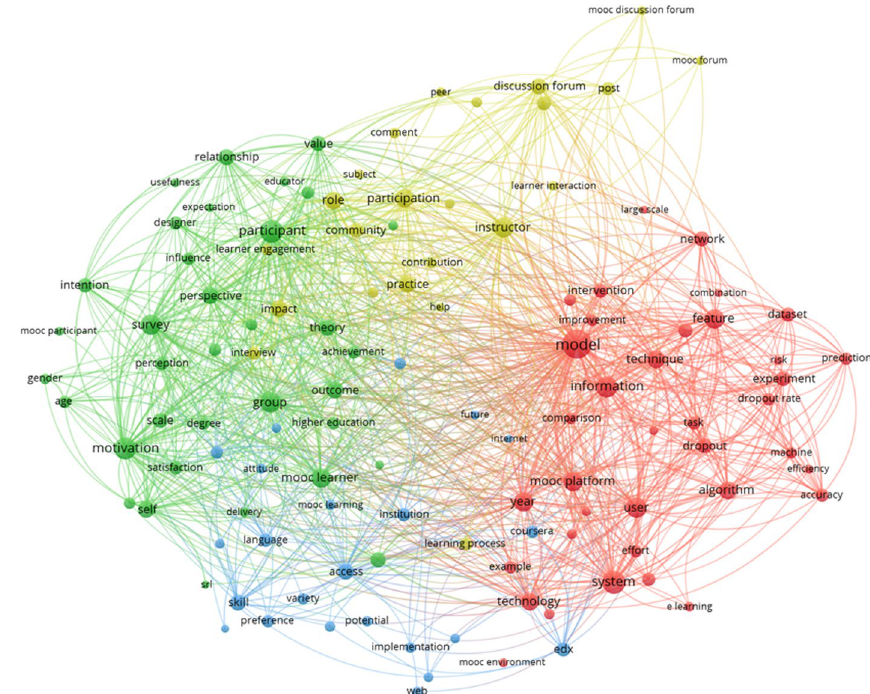
Fig. 6 Thematic cluster analytics of MOOCs. Network